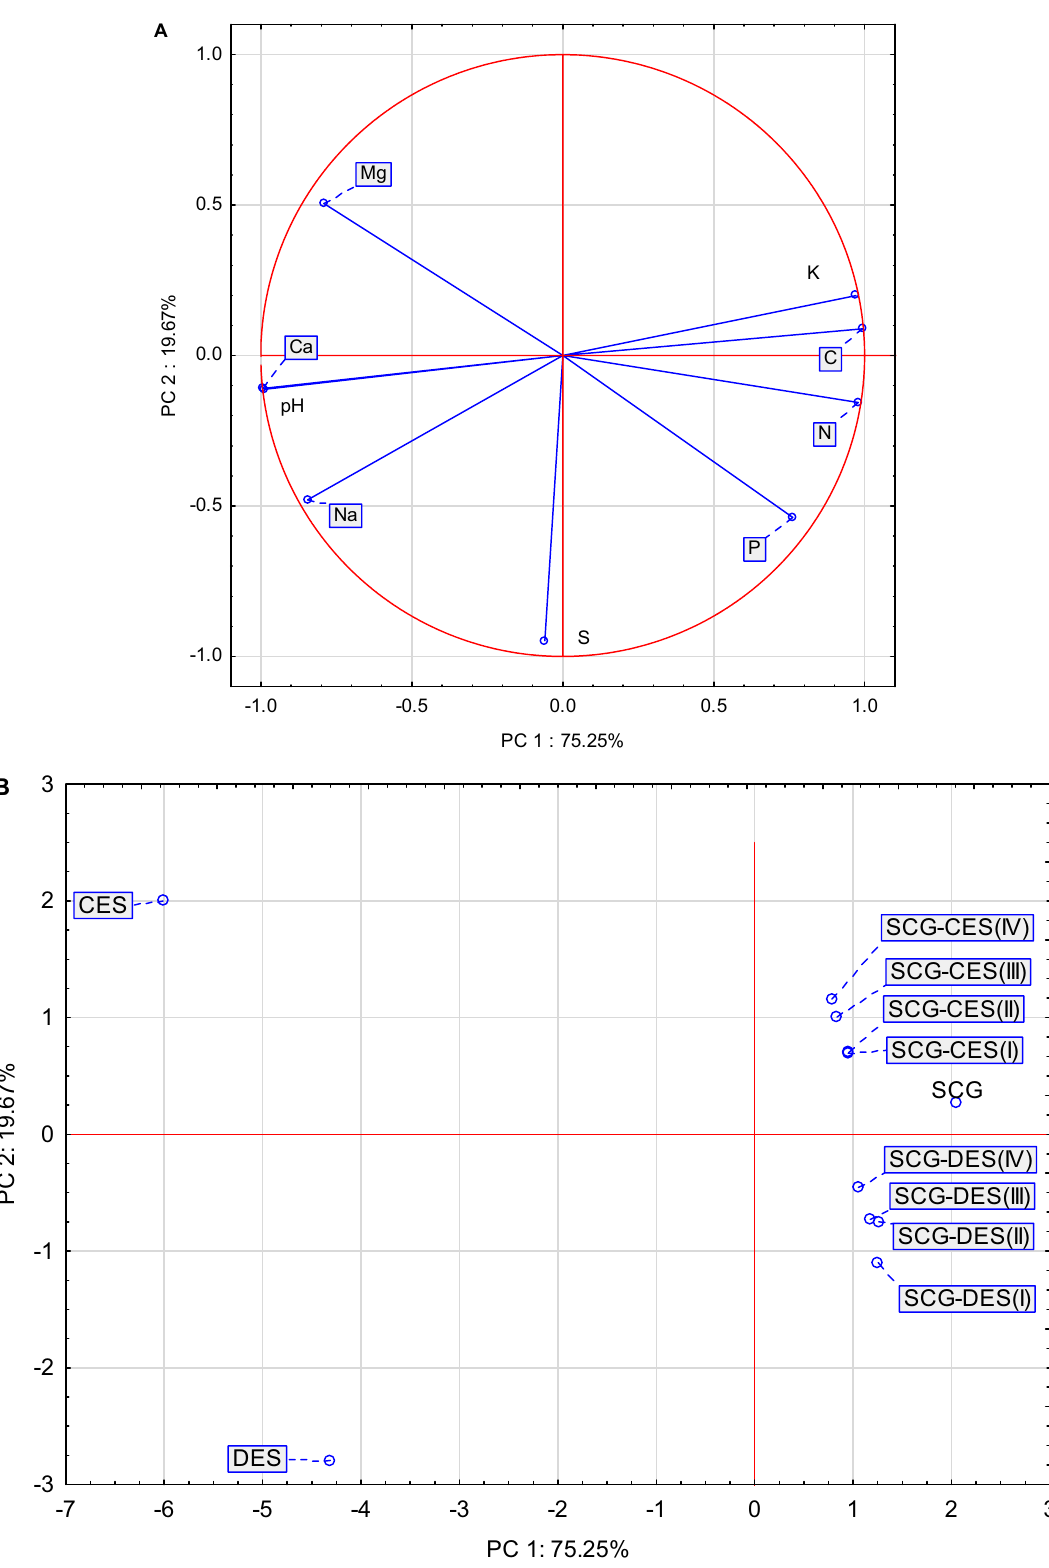
Figure 1. Biplot based on the first two principal component axes for the mineral composition of the mixtures ( A ) and the distribution of 11 mixtures based on the first two components obtained from the principal component analysis ( B ). Explanations in Table